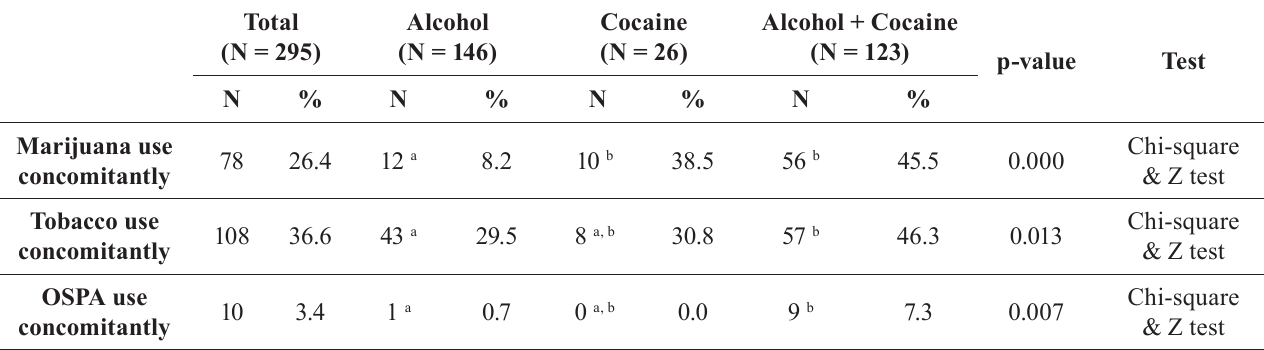
TABLE I - M ain drugs of use, concomitant use of drugs, age and gender of patients attended at CAPS-AD of Betim (MG), Brazil, from January to December